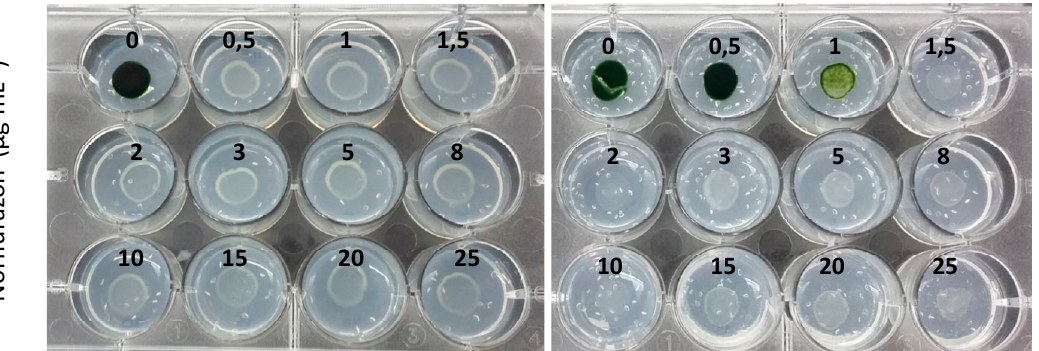
Figure 2. Norflurazon sensitivity test for the clorophyceae microalga Chlamydomonas reinhardtii . Drops (10 µL) of a 100-fold concentrated C. reinhardtii control untransformed culture were spotted on agar-solidified Tris-acetate phosphate (TAP) culture medium with increasing concentrations of the bleaching herbicide norflurazon, and their growth was evaluated 4 ( A ) and 15 ( B ) days after inoculation .